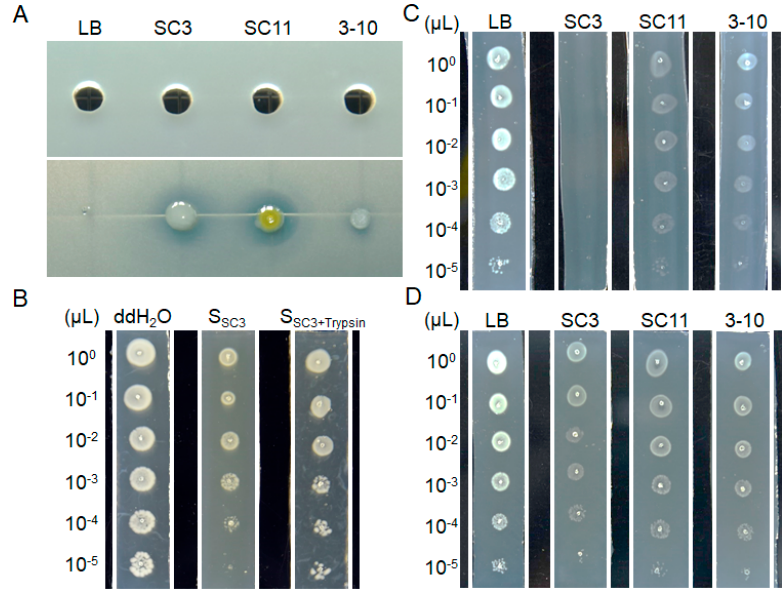
Figure 6. Inhibitory effect of strains SC3, SC11 and 3-10 and their metabolites on the growth of D. zeae MS2. ( A ) Inhibitory activities of the SC3, SC11 and 3-10 supernatants (up panel) and 1 µL of overnight cultures (bottom panel) against MS2 growth; ( B ) Inhibitory activity of SC3 supernatant (SSC3) and its Trypsin enzymatic hydrolysate (SSC3 + Trypsin) against MS2 growth; ( C ) MS2 (OD 600 = 1.5) dilutions respectively grown on the LB agarose, SC3, SC11 and 3-10 metabolite strips; ( D ) MS2 (OD 600 = 1.5) dilutions respectively grown on the LB agarose, and microwave melted SC3, SC11 and 3-10 metabolite strips.